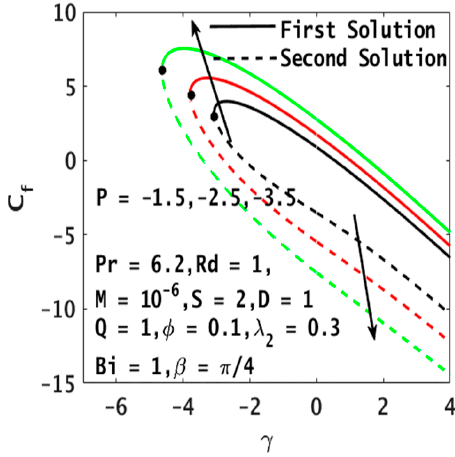
Figure 4. Variation of C (cid:2916) with β .